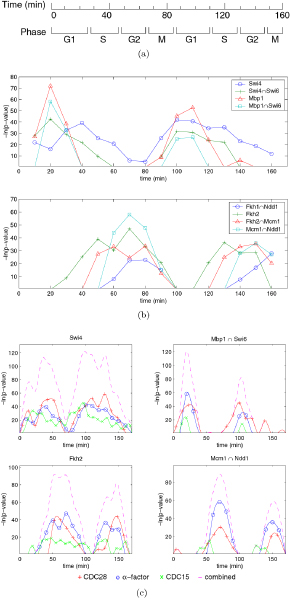
Example rule profiles. (a) Approximate cell cycle phases in CDC28 data set. (b) Rule profiles obtained from CDC28 data set alone. (c) Integrating rule profiles obtained from CDC28, CDC15 and α-factor data sets, aligned on the basis of CDC28 cell cycles.